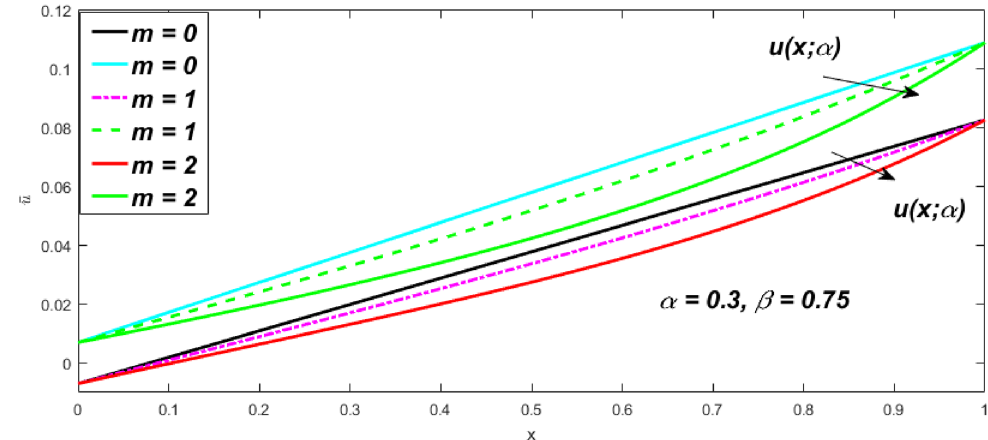
Figure 4. Fuzzy velocity profiles for the impact of m.